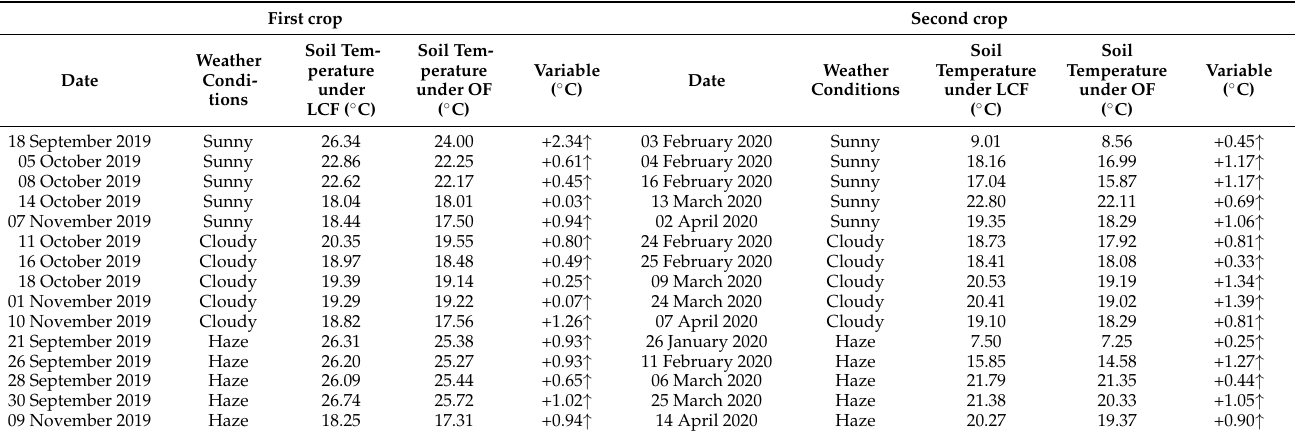
Table 5. Analysis on the effect of different weather on soil temperature, in light conversion film (LCF) and ordinary film (OF) greenhouses, under different